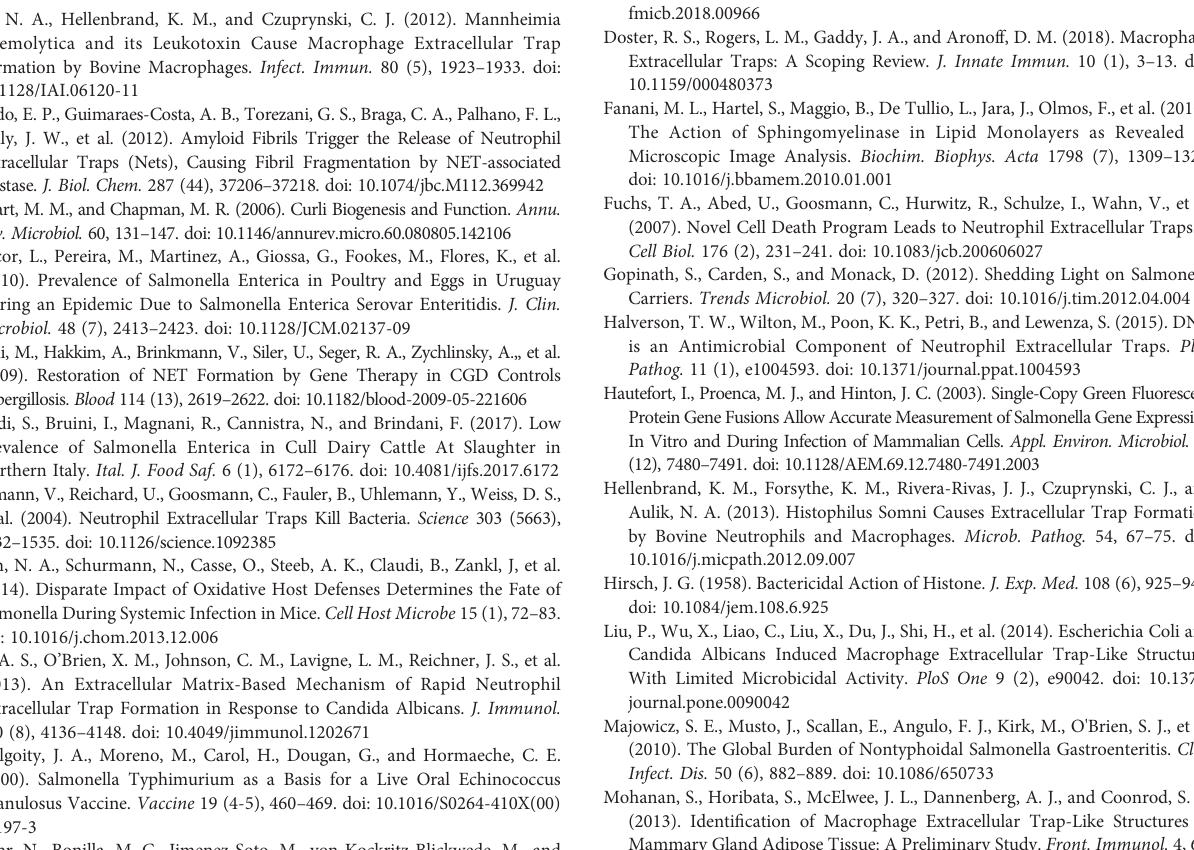
WGA staining (red), DNA (blue), and Salmonella (green). The arrows point out MET release. The scale bar represents 10 µm. Movie 1 | (Still image 1) . Salmonella retention within MET and subsequent bacterial death. Confocal microscopy with time-lapse imaging of J774A.1